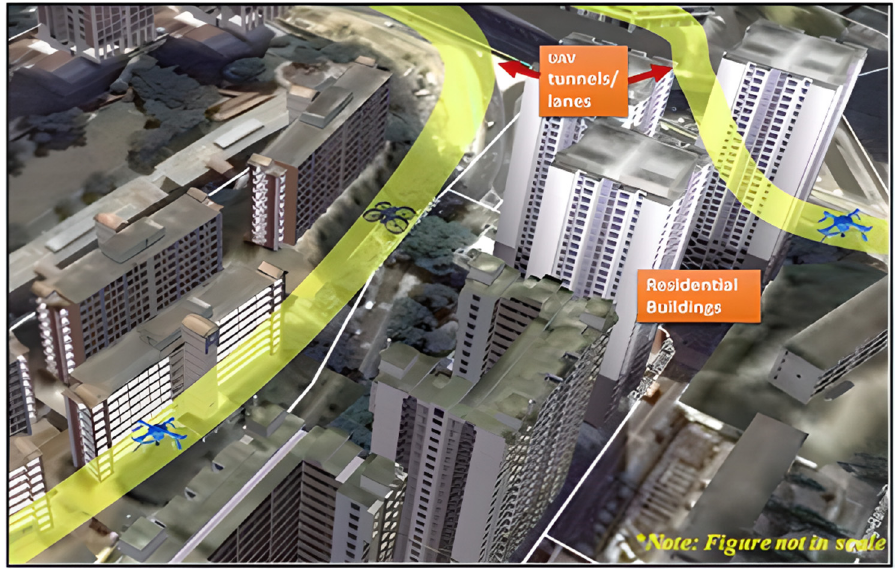
Figure 1. Possible drone lanes/tunnels over high raised urban residential areas (Pathiyil et al. 2016). The routes or lane/tunnels for drone operations over the urban environment are demonstrated in Figure 2. These routes are above or adjacent to land transportation infrastructures in the modern metropolitan cities while keeping a safe distance from moving vehicles and nearby buildings.